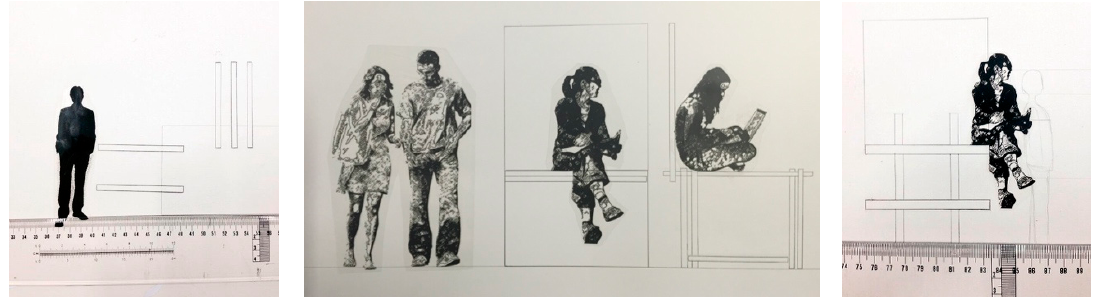
Figure 18. Understanding of scale and spatial occupation through experiment with figure collage. Work sample from Project Part II. Courtesy: Shaikha Al Mulla and Fatima Ismail.